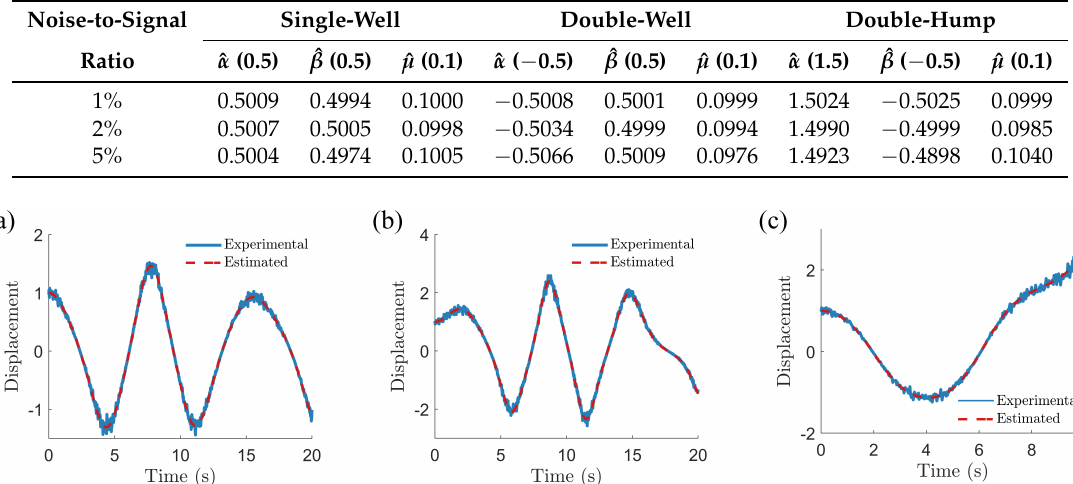
Table 3. Performance of proportional–derivative controller optimization strategy for the van der Pol–Duffing oscillator with measurement noise (experimental parameter values shown in parentheses). Noise-to-Signal